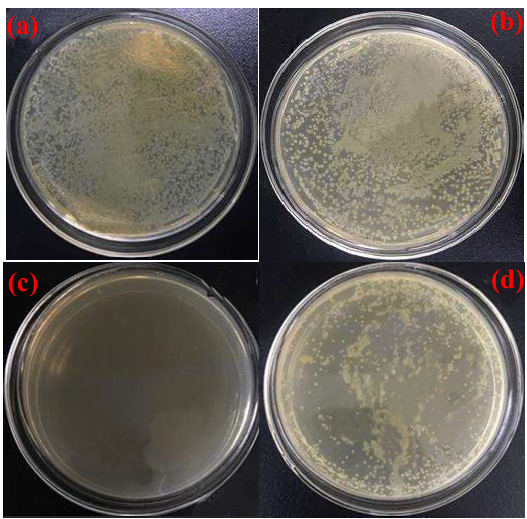
Figure 6. Optical images of agar plates showing the antimicrobial activity: the blank group ( a ), HMQ ( b ), eugenol ( c ), and BPMQ ( d ).